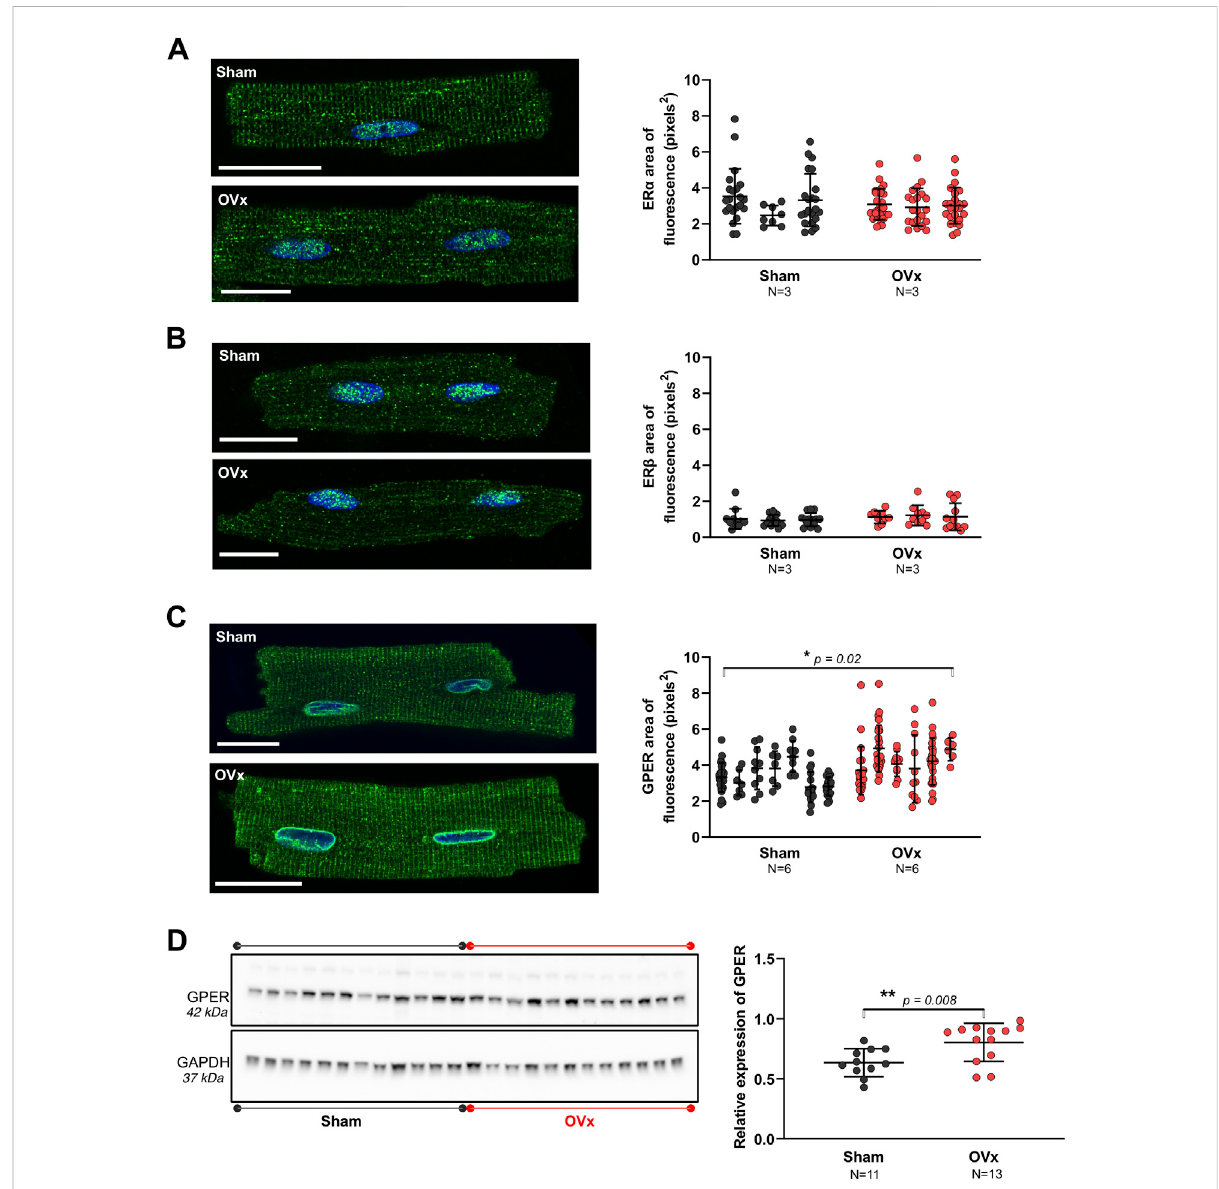
FIGURE 1 The presence of oestrogen receptors in sham and OVx cardiomyocytes. (A) ER α localised to the nuclei and showed some cytosolic staining, with no change in fl uorescence between sham and OVx. Mean ± SD. Student ’ s t-test. Sham n/N = 53/3; OVx n/N = 74/3. (B) ER β was predominantly found in the nucleus, with no difference in OVx. Mean ± SD. Student ’ s t-test. Sham n/N = 40/3; OVx n/N = 31/3. (C) GPER was highly localised to the peri-nuclearERandshowedstriatedstainingwithinthecytosol,whichwashigherinOVxcomparedwithsham.Mean±SD.Student ’ st-test.* p < 0.05, value as indicated. Sham n/N = 96/6; OVx n/N = 101/6. White scale bars = 20 µm. (D) GPER protein expression was higher in OVx compared with sham. Each data point in the graph represents the average protein ratio from each heart from three repeat blots. Mean ± SD. Student ’ s